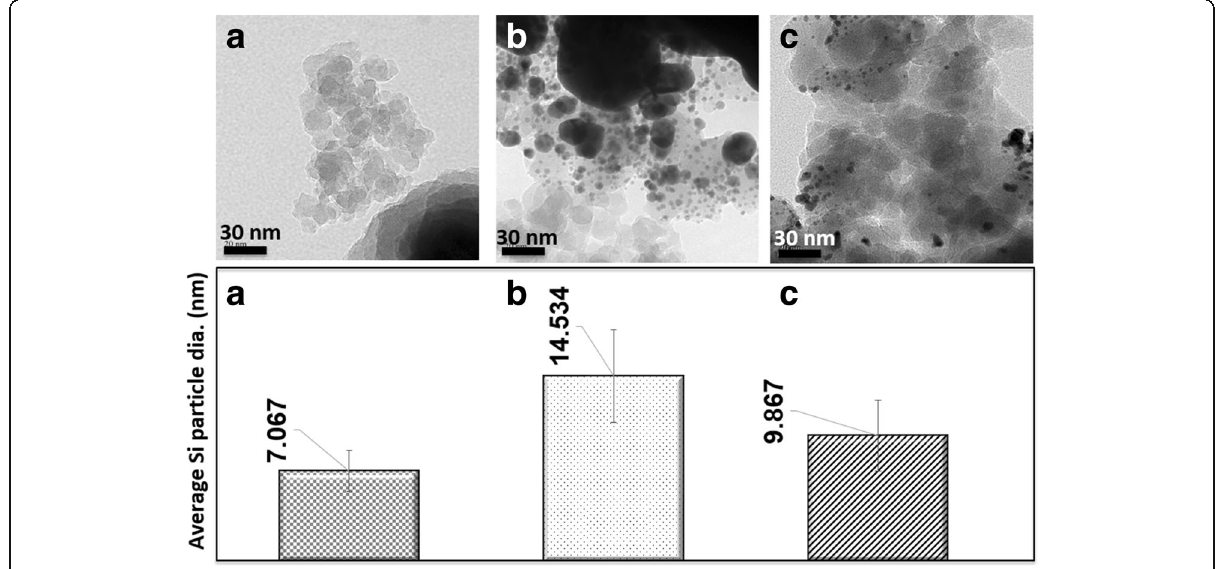
Fig. 10 Average silicon particle diameters of samples gold sputtered for 8 min. a 1 OL 0.025 mm, b 5 OL 0.025 mm, c 5 OL 0.15